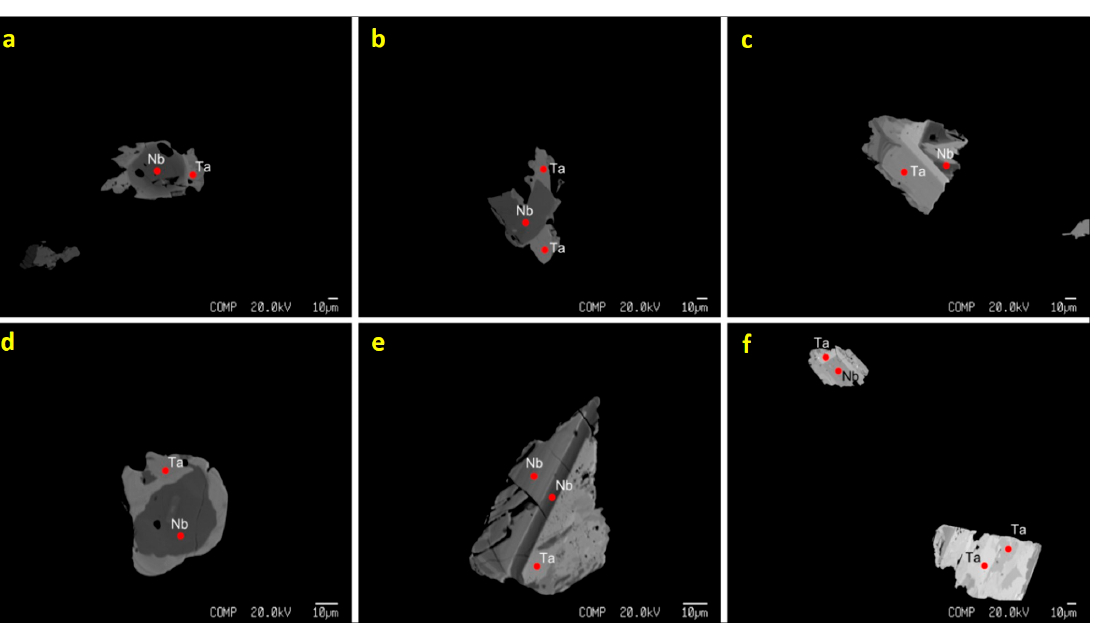
Figure 12. Columbite-tantalite grains analysed by EM PA with clear mineral zoning; ( a , b , d ) Nb-rich cores and Ta-rich rims; ( c , e , f ), convoluted zoning.